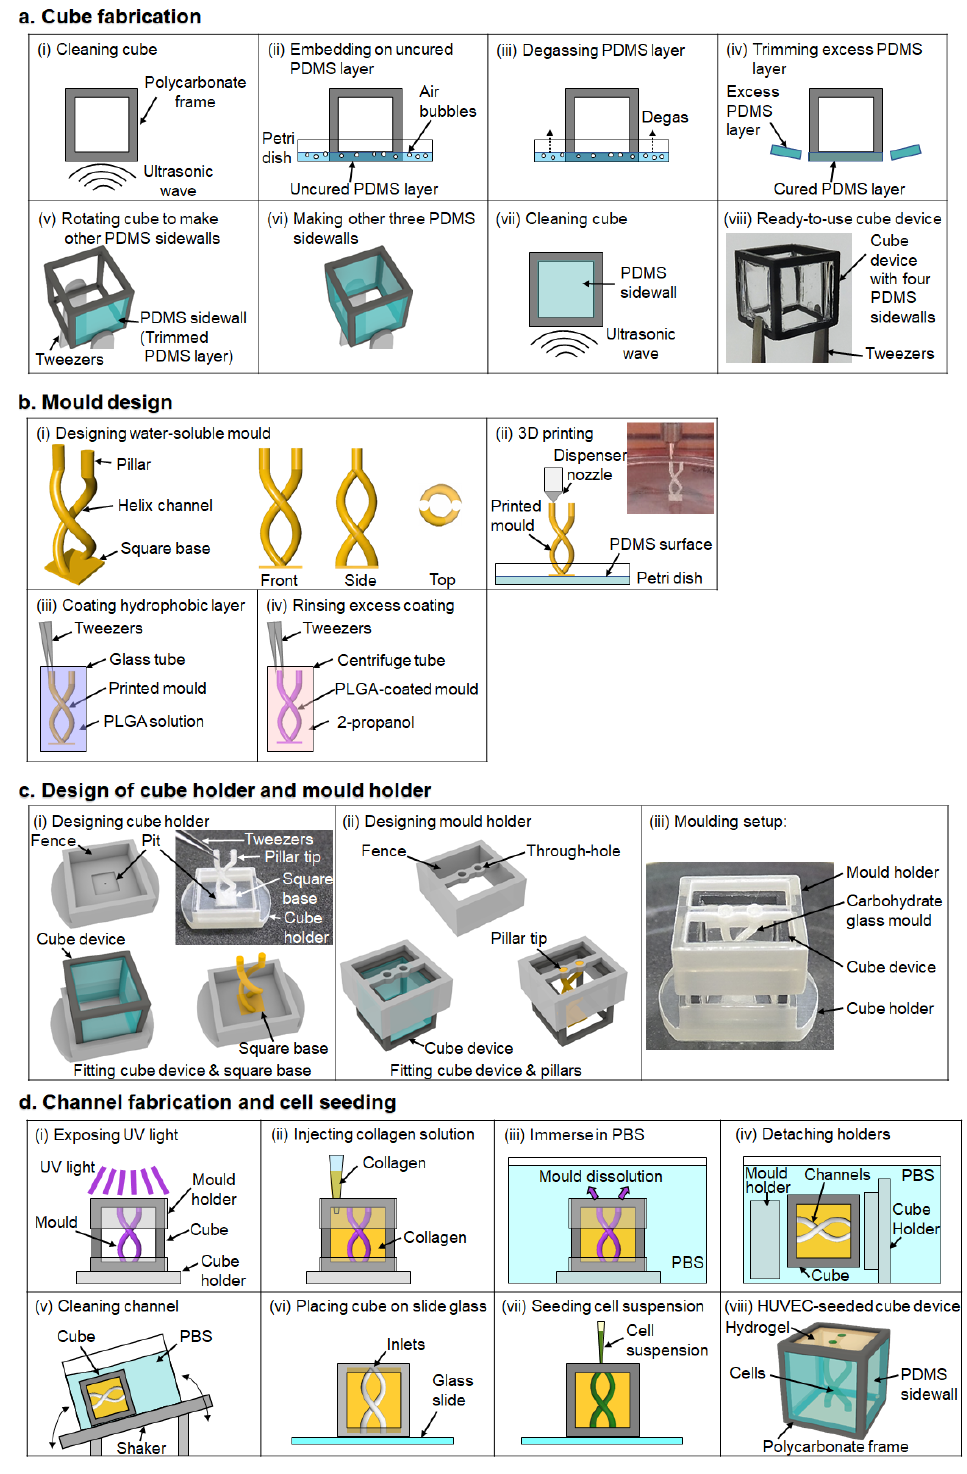
Figure 2. Fabrication processes to control cell distribution in a cube. ( a ) Cube device fabrication. ( b ) Fabrication process of the carbohydrate mold. ( c ) Design of the accessories to align the mold with a cube. ( d ) Process of transferring mold design into ECM to seed cells in a cube.